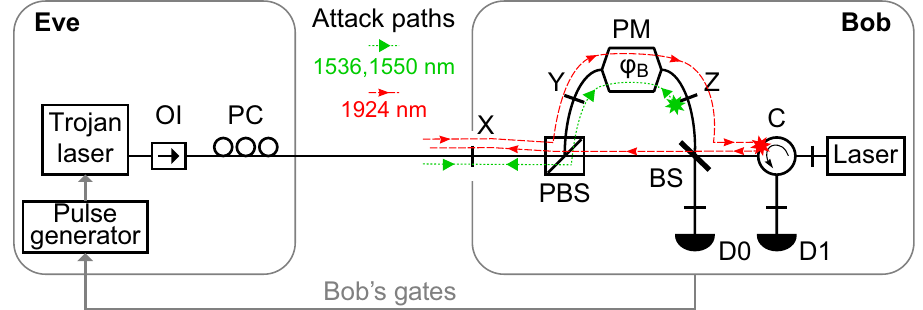
Figure 1. Basic experimental schematic and attack paths at λ s = 1536 nm and λ l = 1924 nm. The scheme and operation of Bob’s setup is described in detail in ref. 13,17 . The stars indicate the back-reflection sources exploited in ref. 11 and in this work. Trojan laser models: Eblana Photonics EP1925-DM-B06-FA at λ l and Alcatel 1905 LMI at λ s . OI, optical isolator; PC, polarization controller; PBS, polarizing beamsplitter; BS, 50:50 beamsplitter; C, circulator; D, single-photon detectors; X, Y, Z, bulkhead fiber-optic